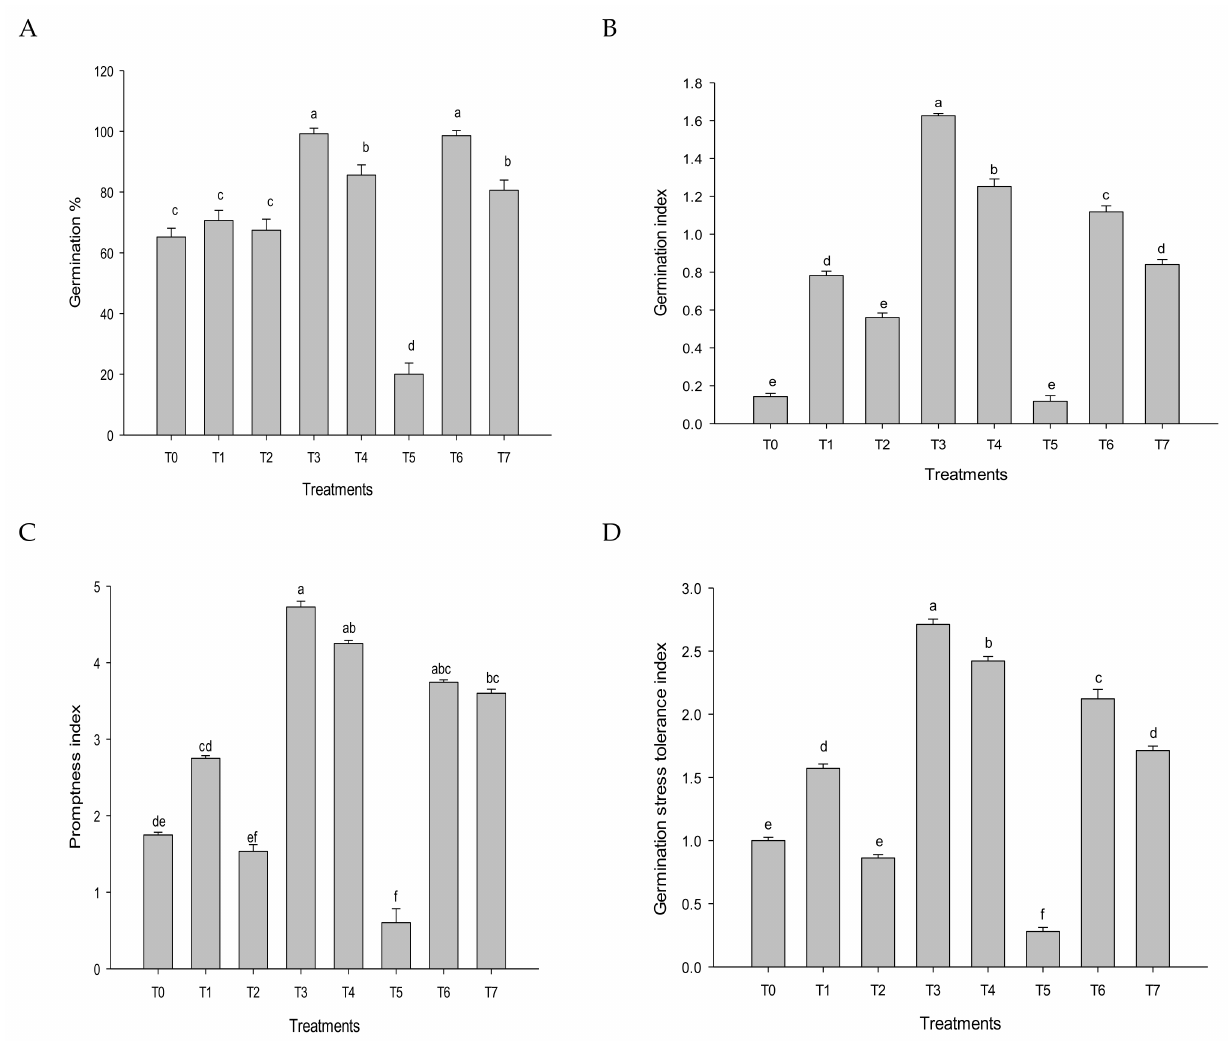
Figure 1. Effect of SWE on mitigating seed germination capabilities of salt-strained tomato seeds; ( A ) Germination Percentage; ( B ) Germination Index; ( C ) Promptness Index; ( D ) Germination Stress Tolerance Index. Mean ( ± SEM) of 5 replicates. Within each time point, the same letter indicates no significant difference ( p ≤ 0.05) in a Tukey’s test. (T0—Control, T1—NC, T2—NC + S150